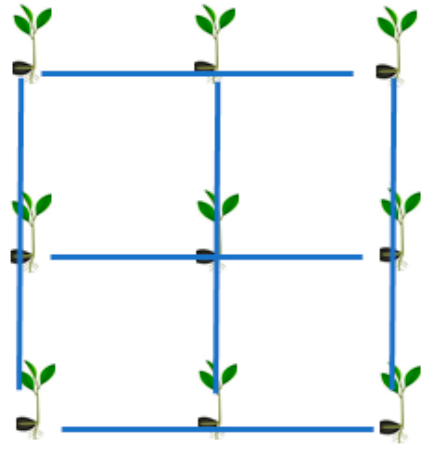
Figure 1. Square pattern of planting.